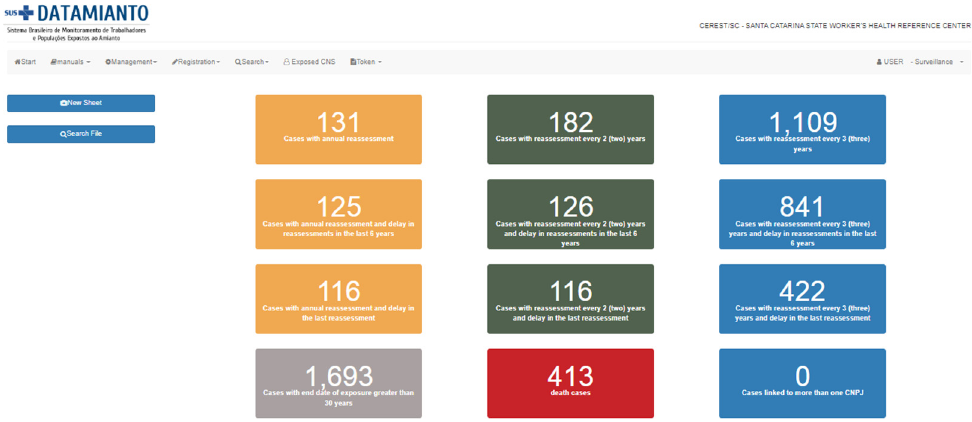
Figure 2. Access to the surveillance module, and its alerts in the Datamianto system. Source: Datamianto system, Santa Catarina State Cerest, Brazil,